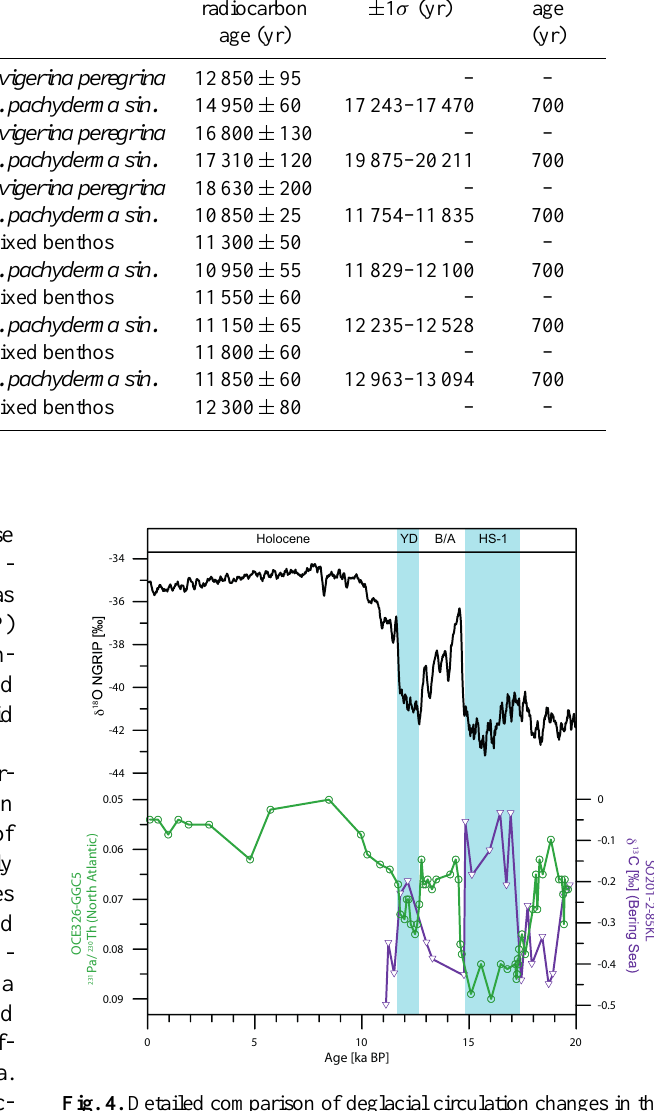
( − 0.6 ‰) and the YD ( − 0.3 ‰) and thus characterizes